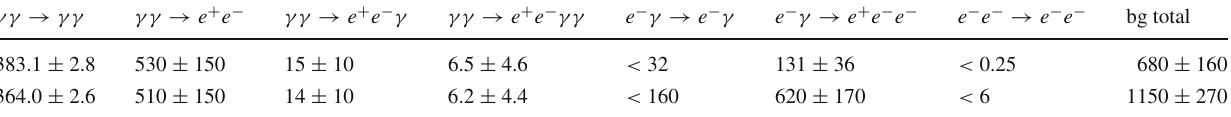
The numbers in the first row are for the case with (electron bunch charge, laser pulse energy) = (0.4 nC, 2 J) and those in the second row are for (2 nC, 0.4 J). (See Sect. 4 for details). Errors are from statistics of the MC